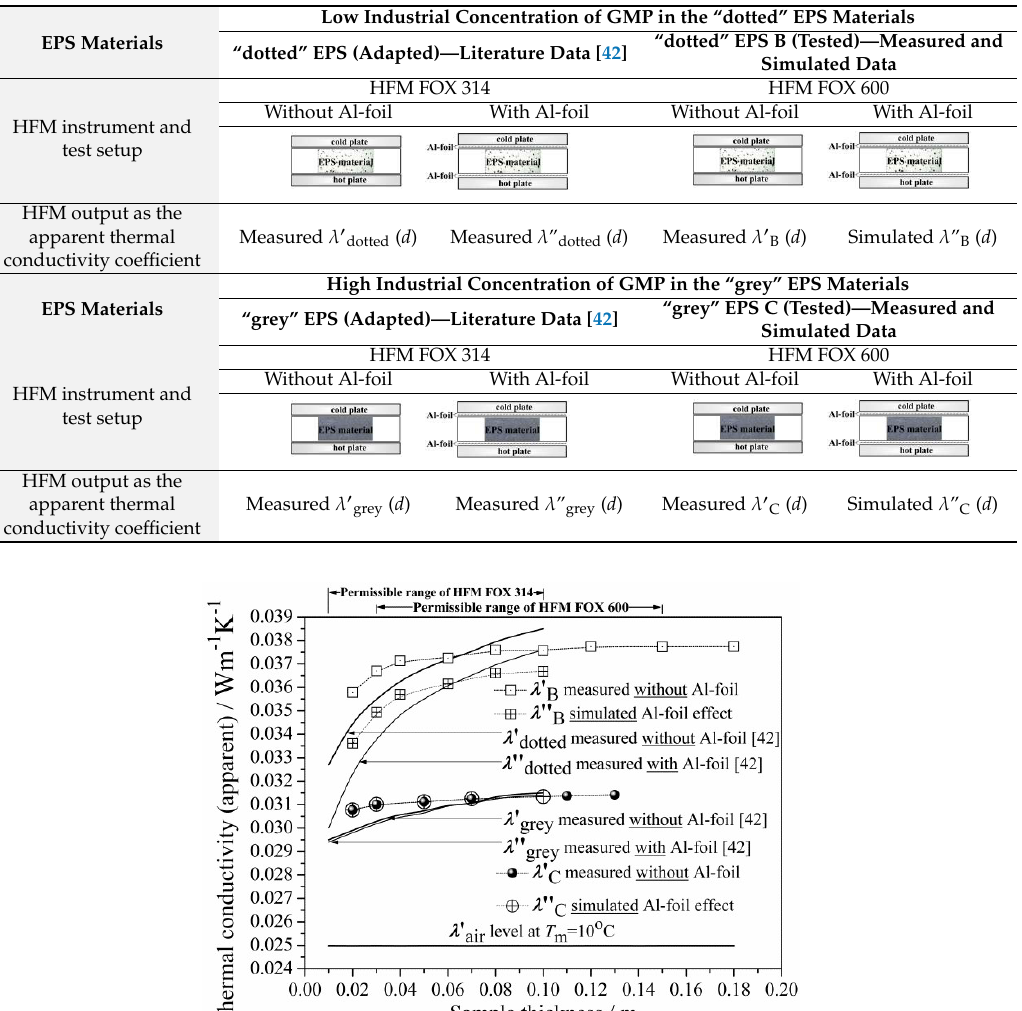
Table 4. A brief comparison of EPS B and C (tested) with the corresponding EPS (“dotted” and “grey”) from [42] (marked as literature data) and the list of HFM instruments with test setup and output data.